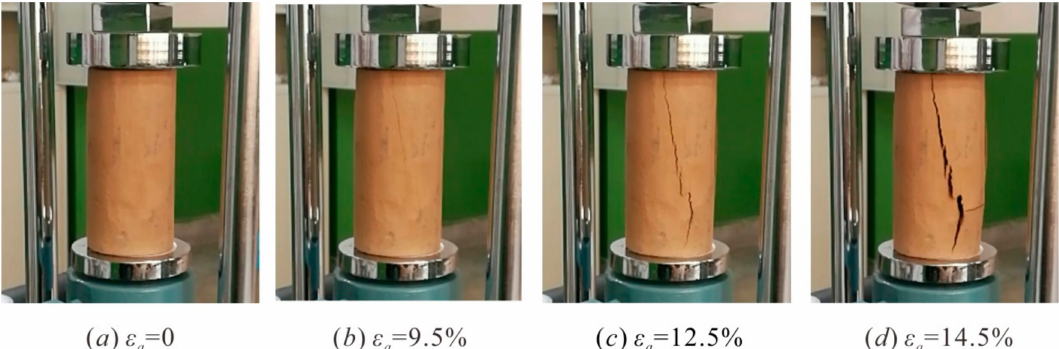
Figure 4. A complete destruction process of the undisturbed sample (taking the sample 1-1 as the example): ( a ) the initial state of the sample, ( b ) the phase of the elastic deformation, ( c ) the failure of the sample, and ( d ) the residual deformation phase.